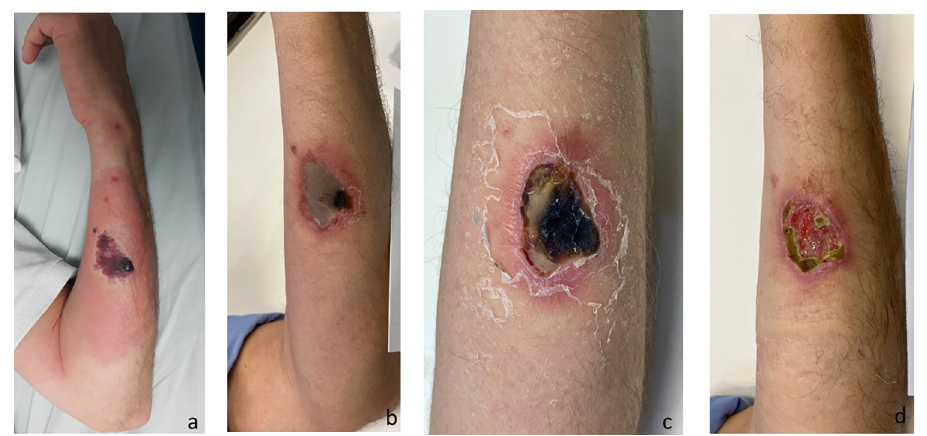
Fig 5. Evolution of a cutaneous lesion after a Loxosceles sp. bite, from marbled macula to necrosis and ulcer. (a) 4 days after the bite; (b) 17 days after the bite; (c) 24 days after the bite; (d) 31 days after the bite.